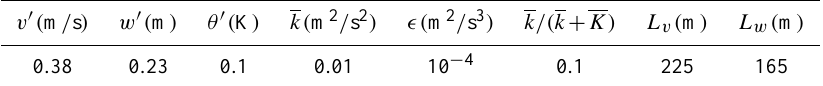
Table 2. Parameters of the synthetic turbulence generated in the diffusion regime: v 0 , w 0 , horizontal and vertical velocity fluctuations; θ 0 , potential temperature fluctuations; k , turbulent kinetic energy; (cid:15) , eddy dissipation rate; k/(k + K) , ratio between the resolved and the total kinetic energy; L v , L w , size of horizontal and vertical